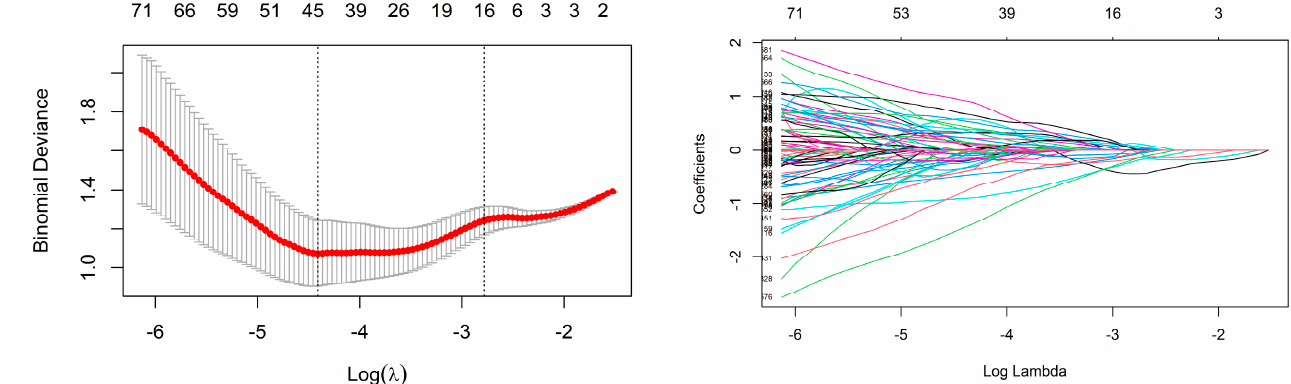
Figure 3. LASSO features selection.